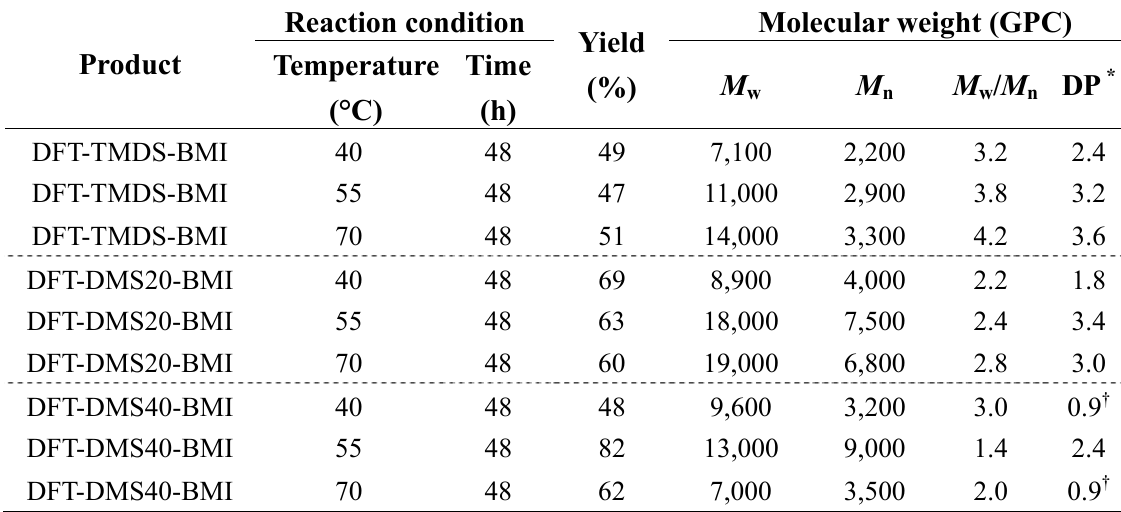
Table 1. Diels-Alder polymerization of DFTreh with siloxane oligomers. DMF was used for TMDS-BMI and DMS20-BMI; and dioxane for